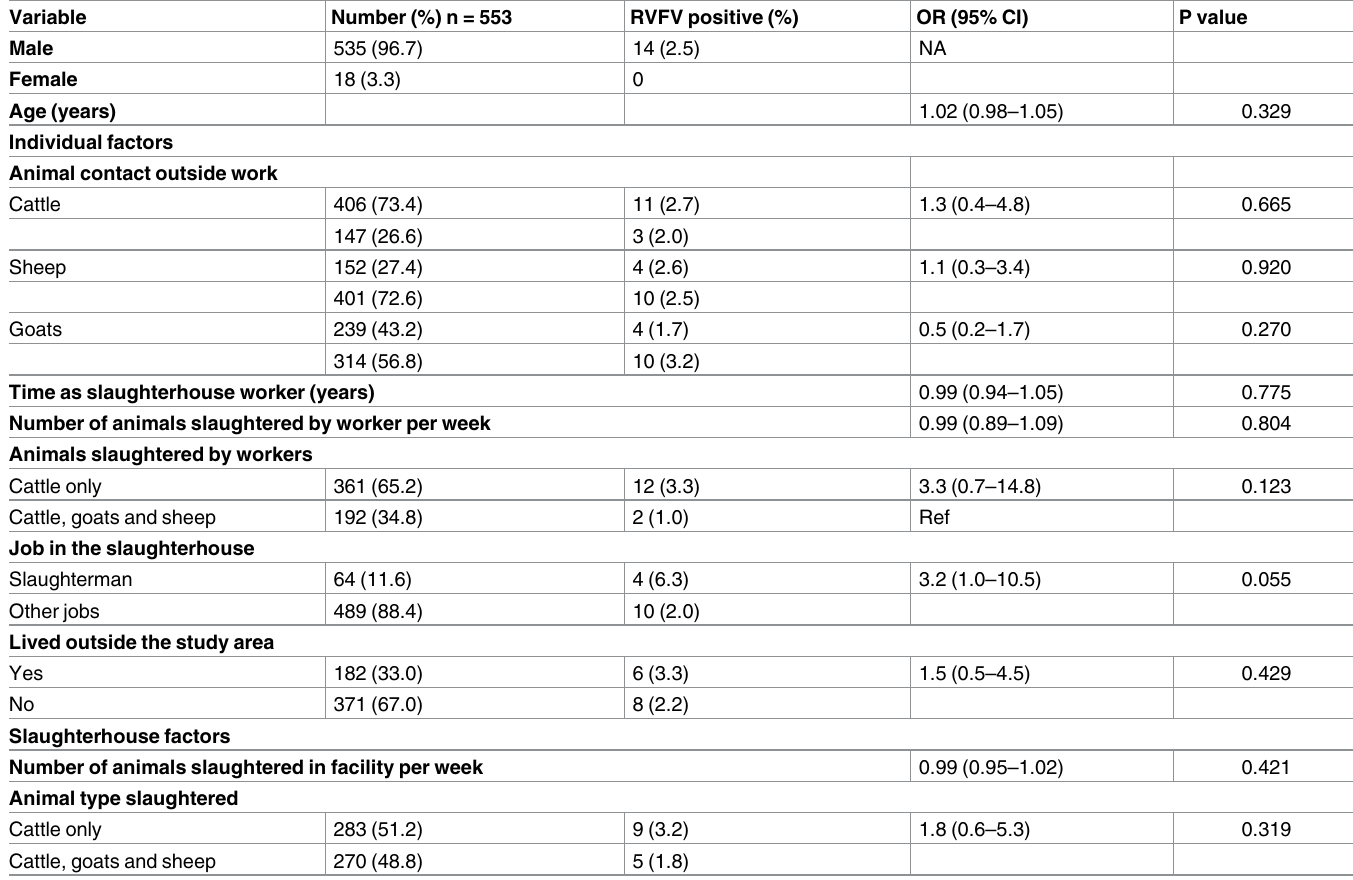
Table 3. Results of univariable analysis for risk factors for RVFV seropositivity in slaughterhouse workers.